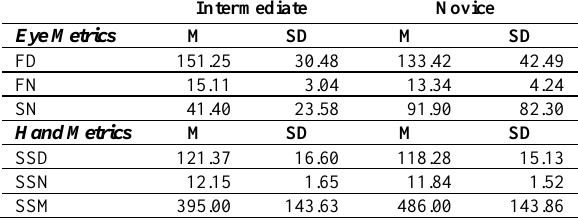
Table 5. Descriptive Results for the Metrics in Scenario-2 Intermediate